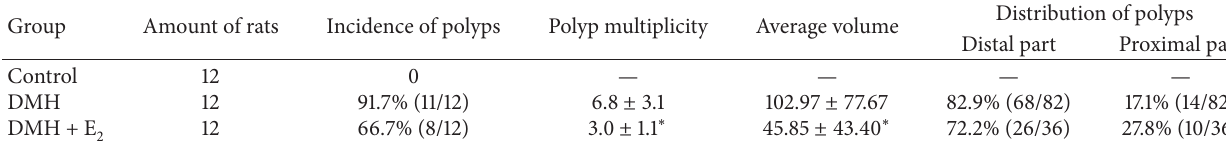
Table 2: The incidence, multiplicity, average volume, and distribution of colon polyps.